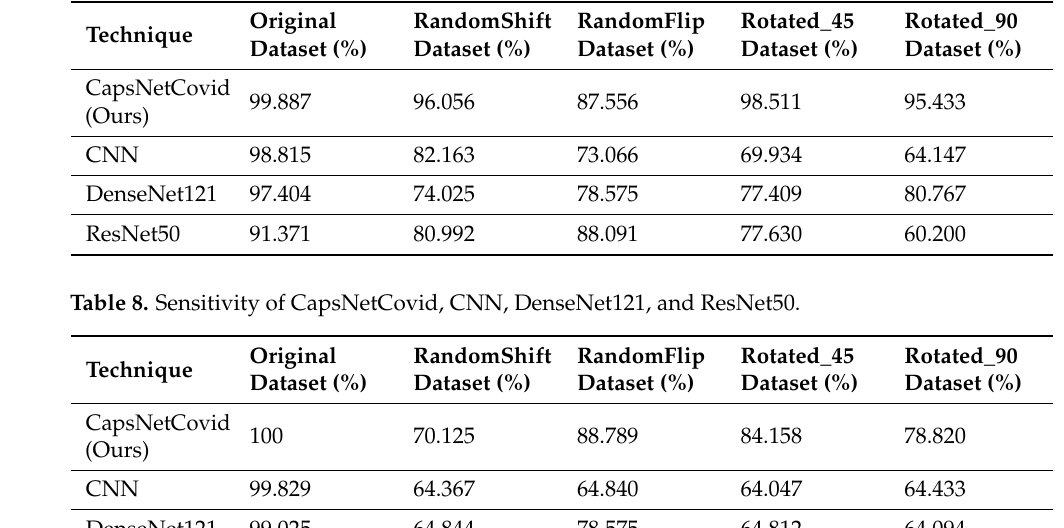
Table 7. Precision of CapsNetCovid, CNN, DenseNet121, and ResNet50.